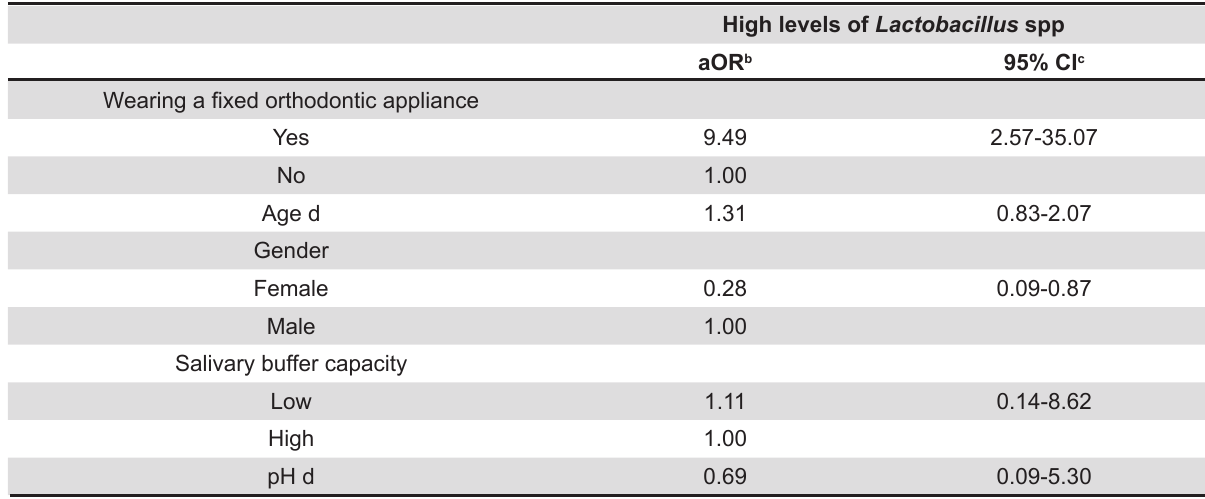
a: Logistic regression model adjusted for all potential predictors reported in the table b: Adjusted Odds Ratio c: 95% Confidence Interval of the